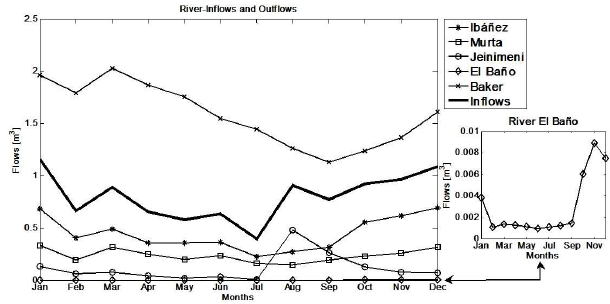
Fig. 5. Monthly mean river discharges and total fluvial inputs into Lake General Carrera/Buenos Aires/Chelenko.